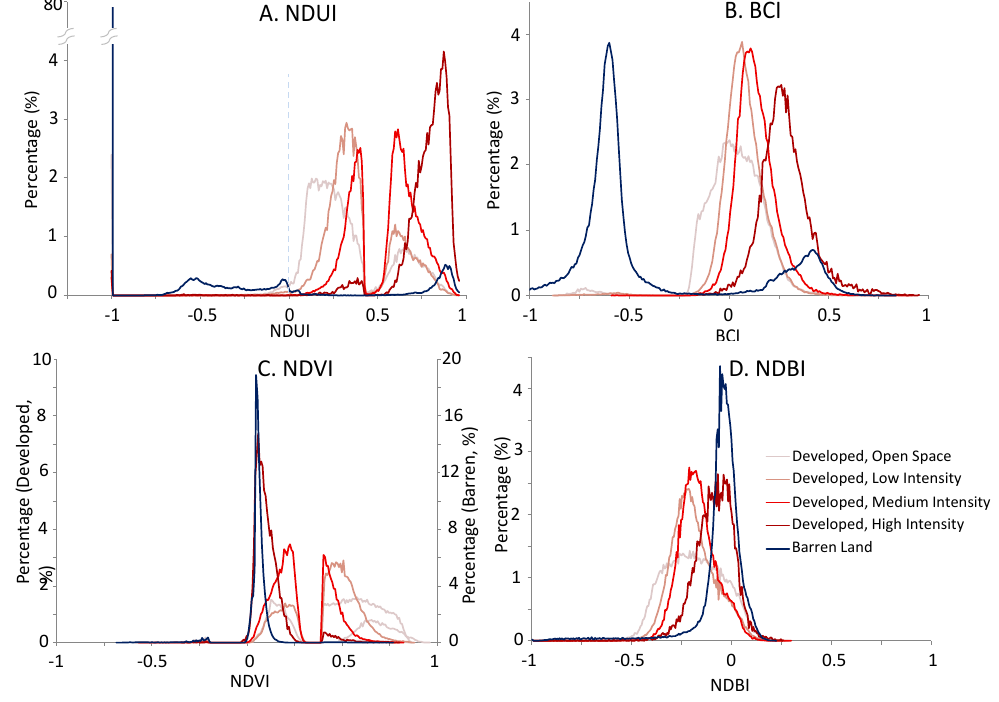
Figure 13. Distributions of NDUI ( A ), BCI ( B ), NDVI ( C ), and NDBI ( D ) within both the NLCD 2006 barren land class and the Developed classes in the two evaluation